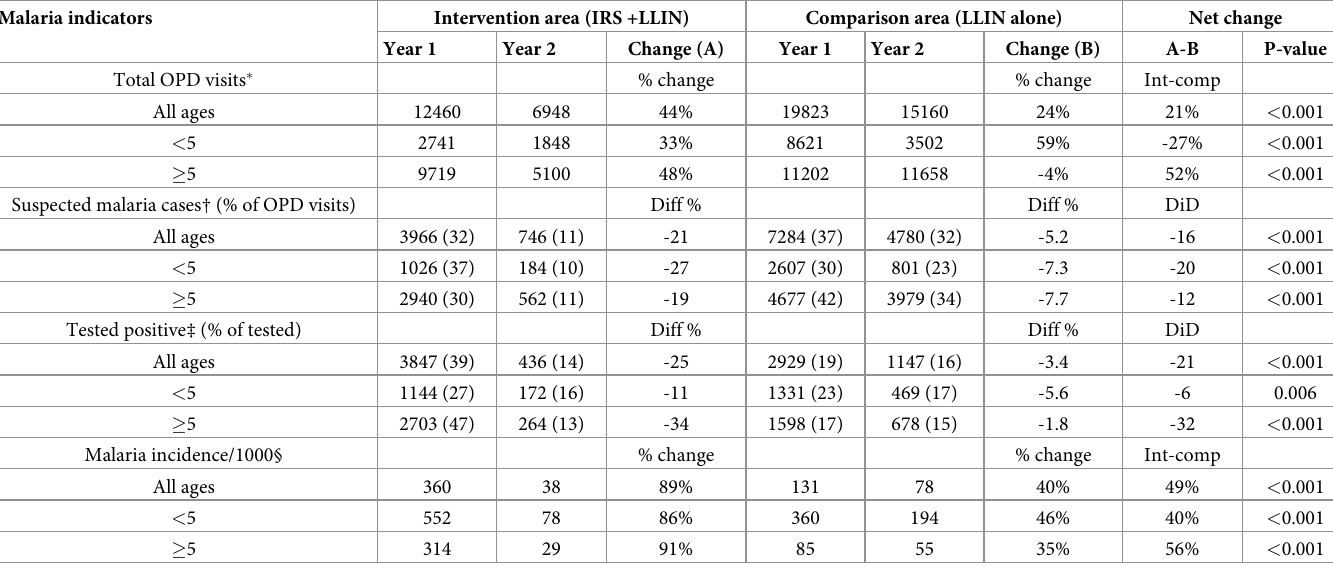
Table 1. Changes in annual malaria indicators in the intervention area and comparison area before and after the introduction of the first round of IRS, 2016–2017. Malaria